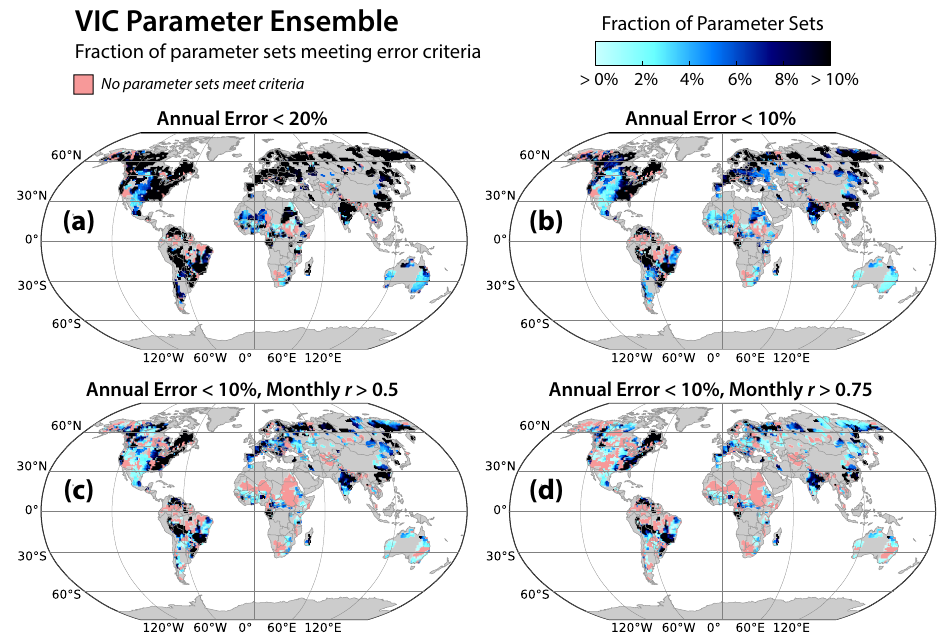
Figure 2. Fraction of parameter sets from the 10000 Latin hypercube VIC ensemble that fulfill a set of criteria. The comparison is between the annual and monthly climatology of simulated runoff and the GRDC database. The grey areas are regions that are not covered by the GRDC database.